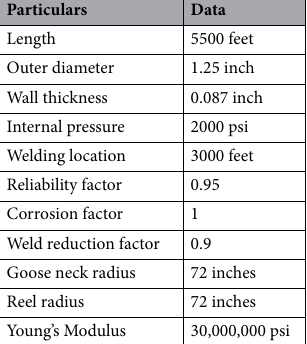
Table 10. Information on HOC job with CT (2000 psi).